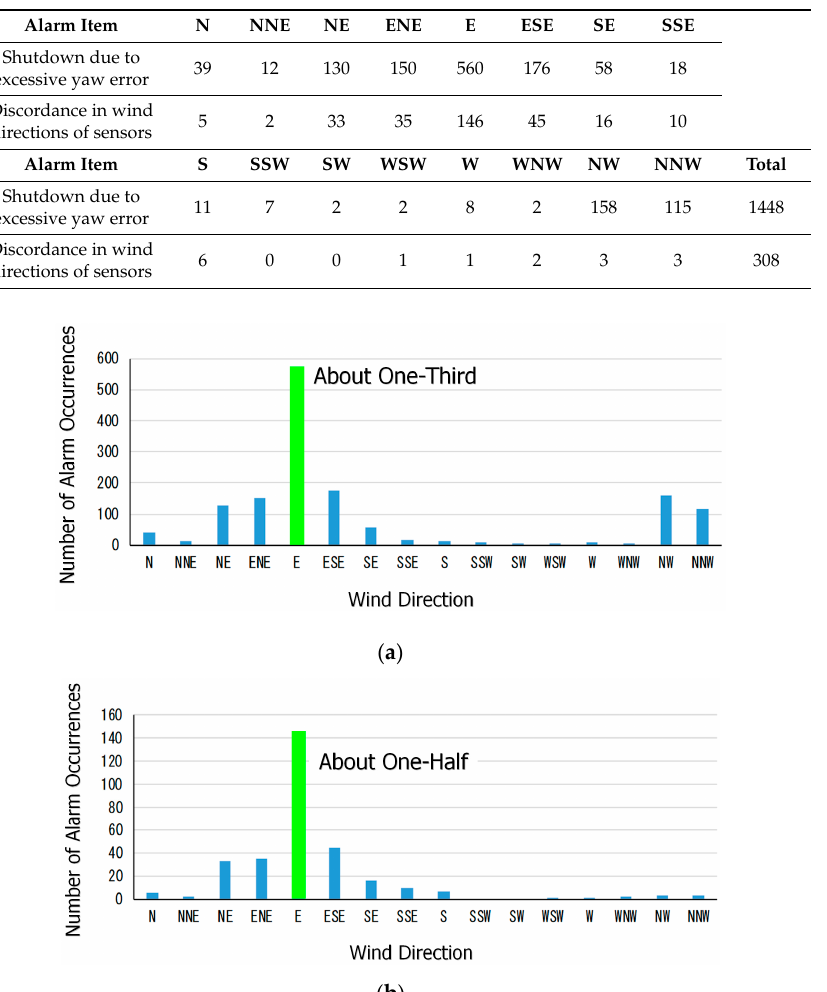
Figure 8. Result of graphing the values in Table 3. ( a ) Number of alarm occurrences for yaw misalignment. ( b ) Number of alarm occurrences for wind direction mismatch of the wind vane. Note: Wind turbine systems resort to shutting down the wind turbine if the yaw misalignment exceeds a threshold.